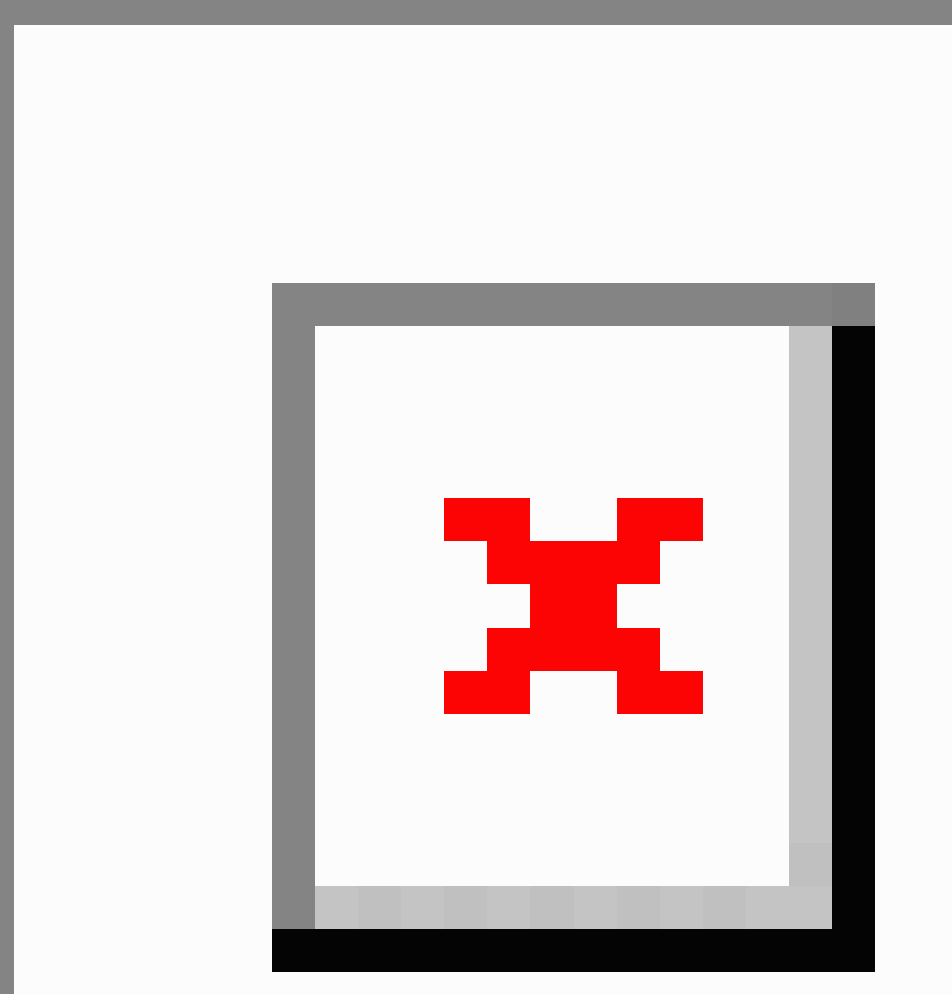
Figure 3. Replies from teenagers in an attention-deficit hyperactivity disorder (ADHD)